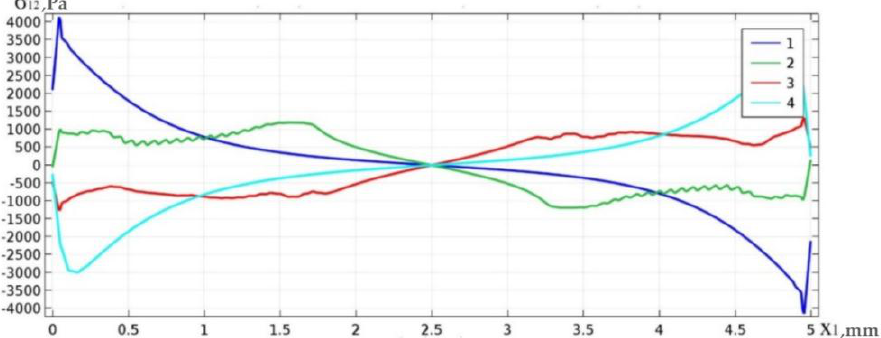
Figure 3. Curves of shear stress distribution on the upper (1,2) and bottom (3,4) boundary of the solder joint area.